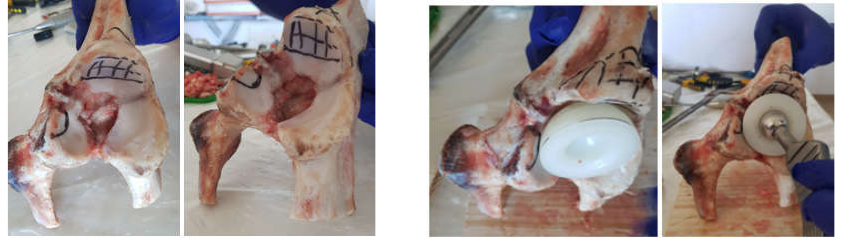
Figure 8. Marking the areas to be removed from the iliac bone.